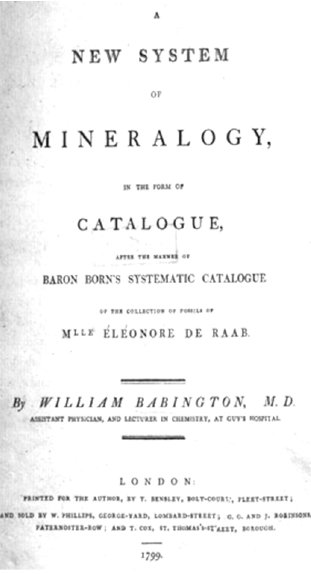
Figure 5. Babington’s New System of Mineralogy [26] based on the de Raab